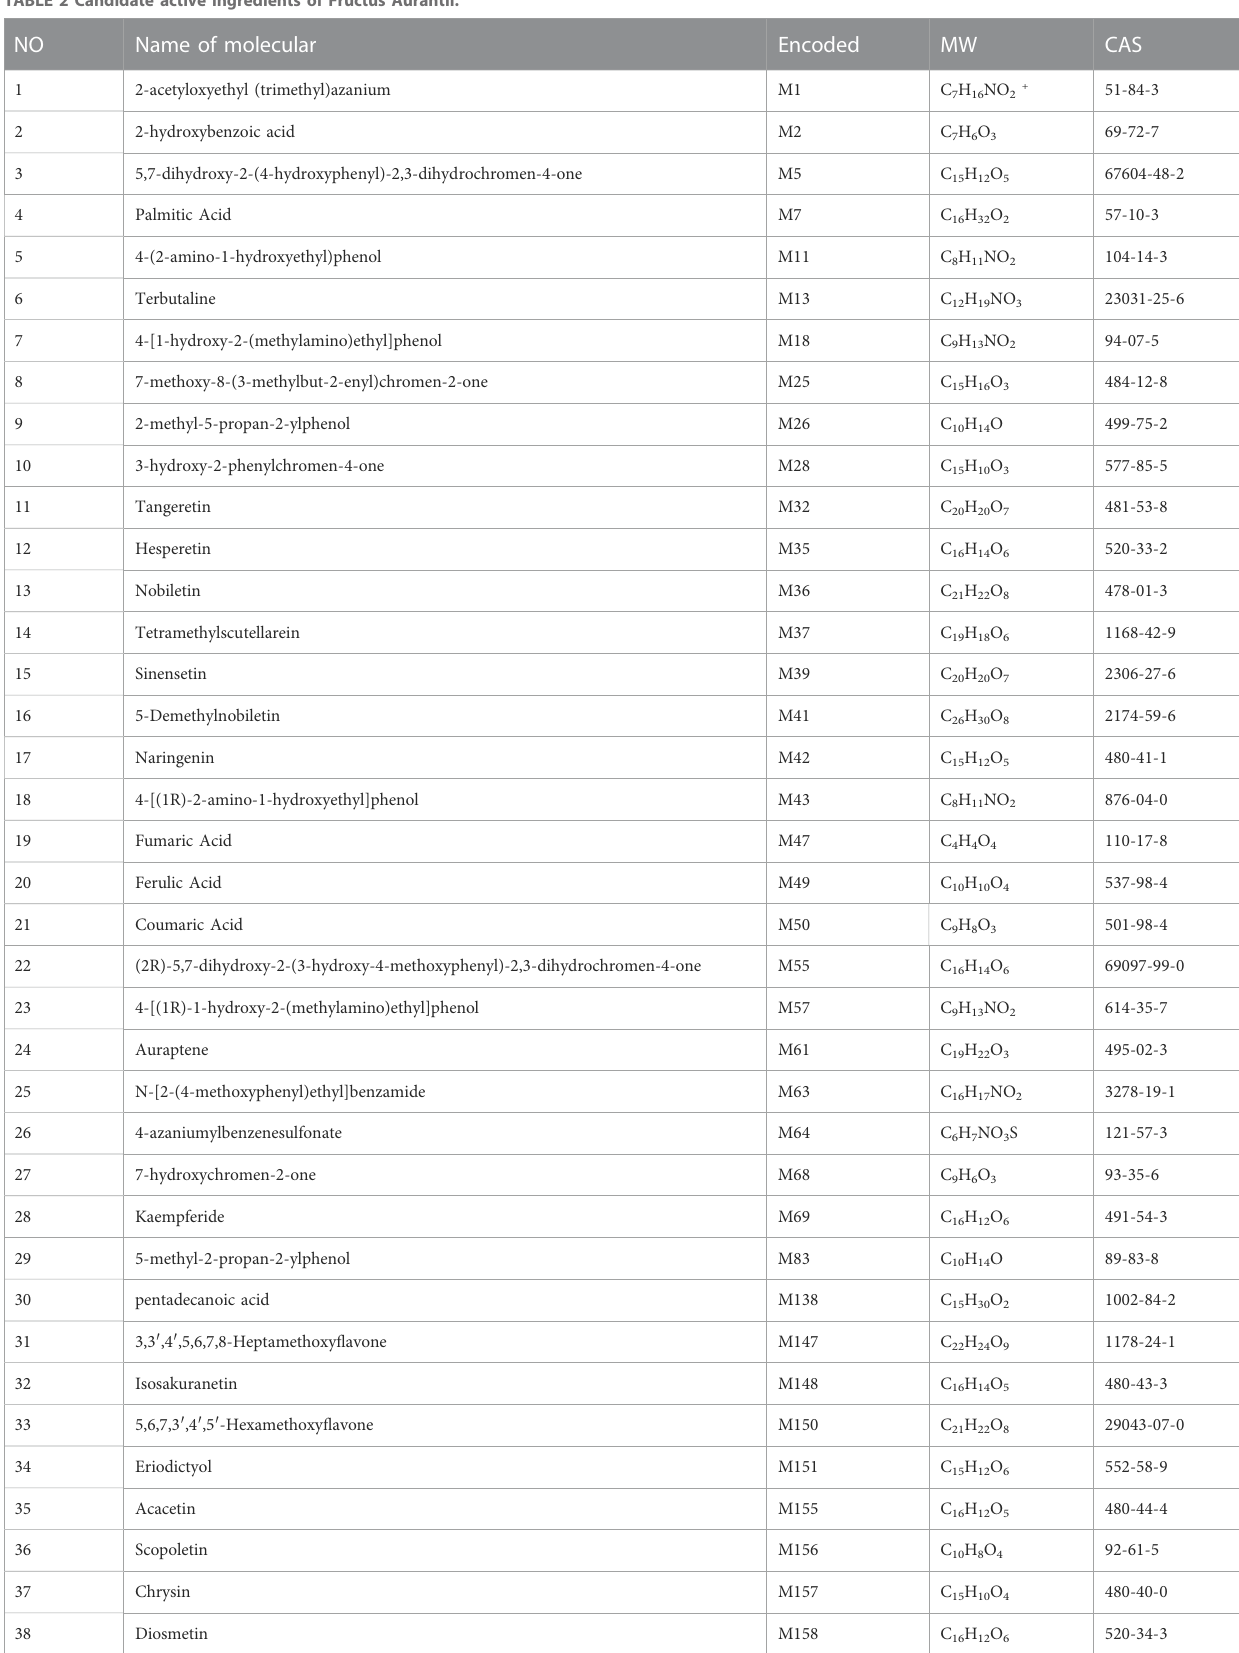
TABLE 2 Candidate active ingredients of Fructus